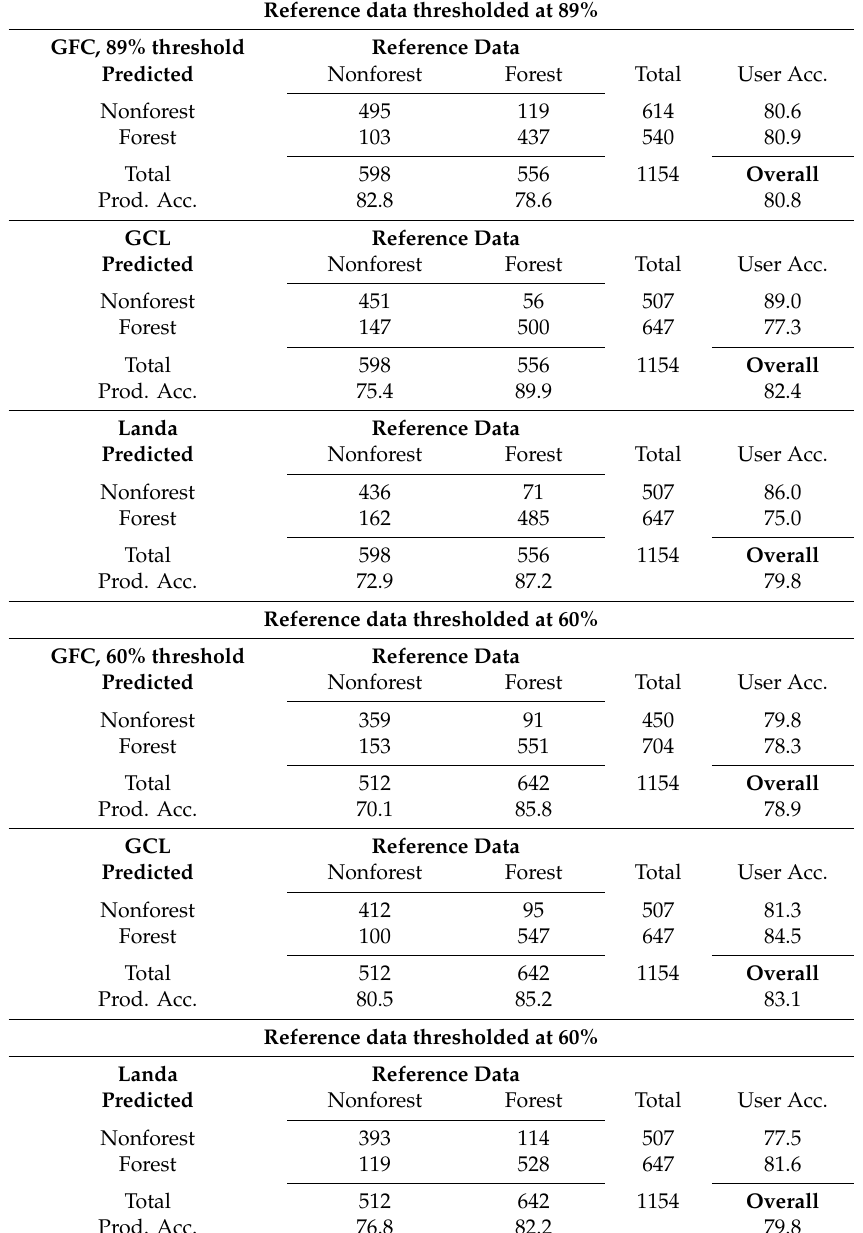
Table A1. Detailed confusion matrices showing the accuracy of di ff erent forest / non-forest maps at three forest cover thresholds (30%, 60%, and 89%). Producer’s accuracy and user’s accuracy are abbreviated